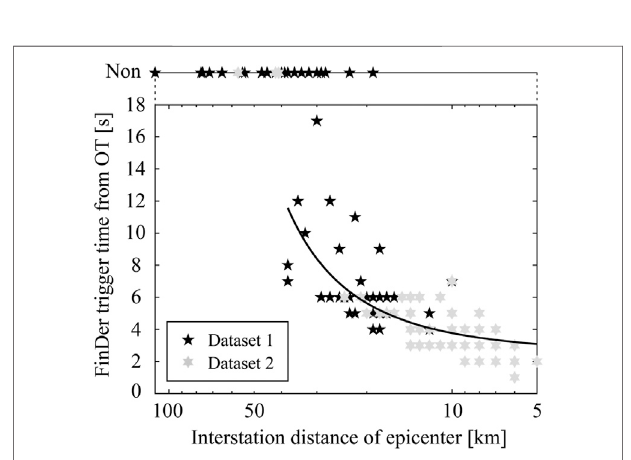
FIGURE 12 | Relationship between the interstation distance, D epi , de fi ned as the average distance between the epicenter to the three closest stations, and FinDer trigger time from OT, T trig